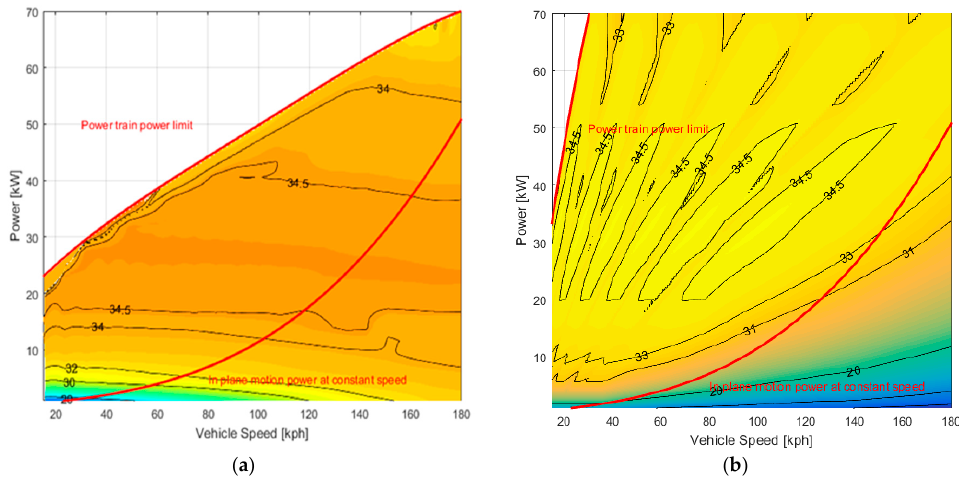
Figure 16. ICE efficiency [%] contour map as a function of road variables: ( a ) CVT ; and ( b ) DVT .